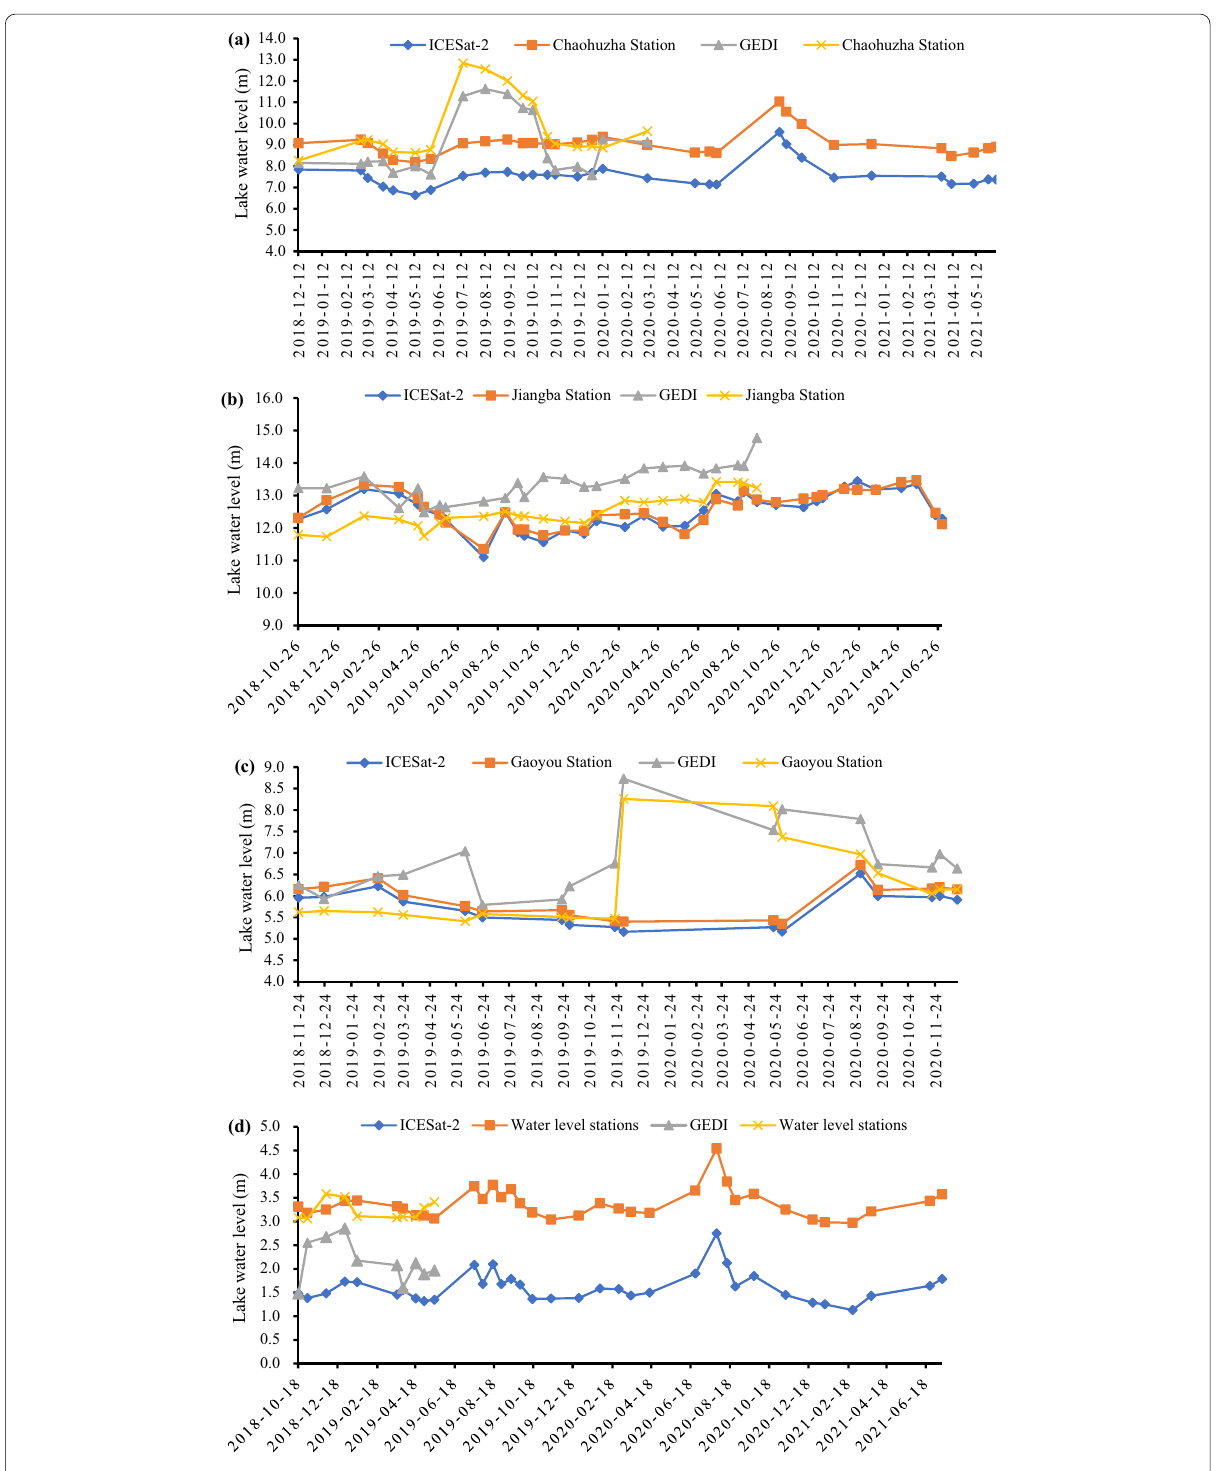
Fig. 2 Consistency evaluation of ICESat-2 and GEDI estimated lake levels (the timeline is based on ICESat-2 acquisition dates) with in situ measurements for a Chaohu Lake, b Hongze Lake, c Gaoyou Lake, and d Taihu